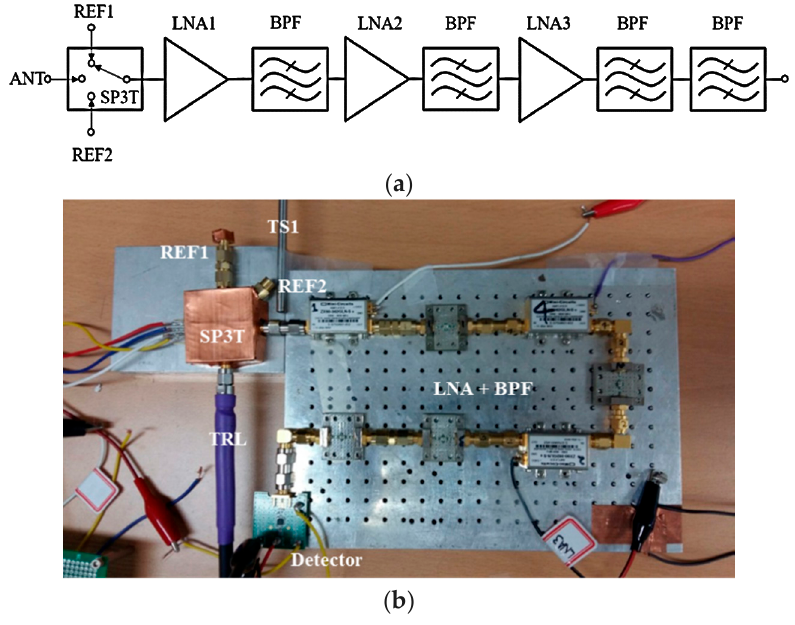
Figure 3. Designed direct-conversion receiver. ( a ) Block diagram. ( b ) Photograph.